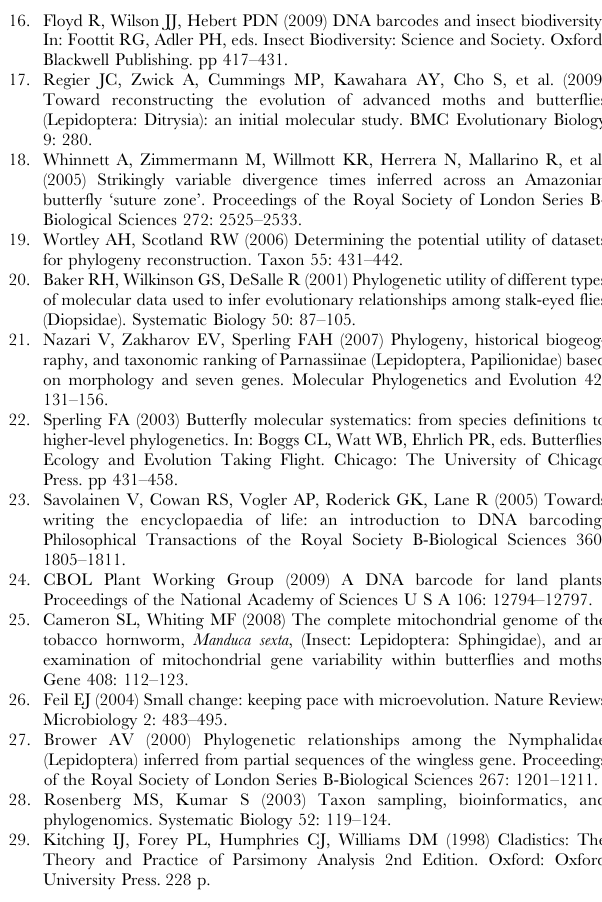
Table S2 Sequences used in phylogenetic utility and phyloge- netic signal